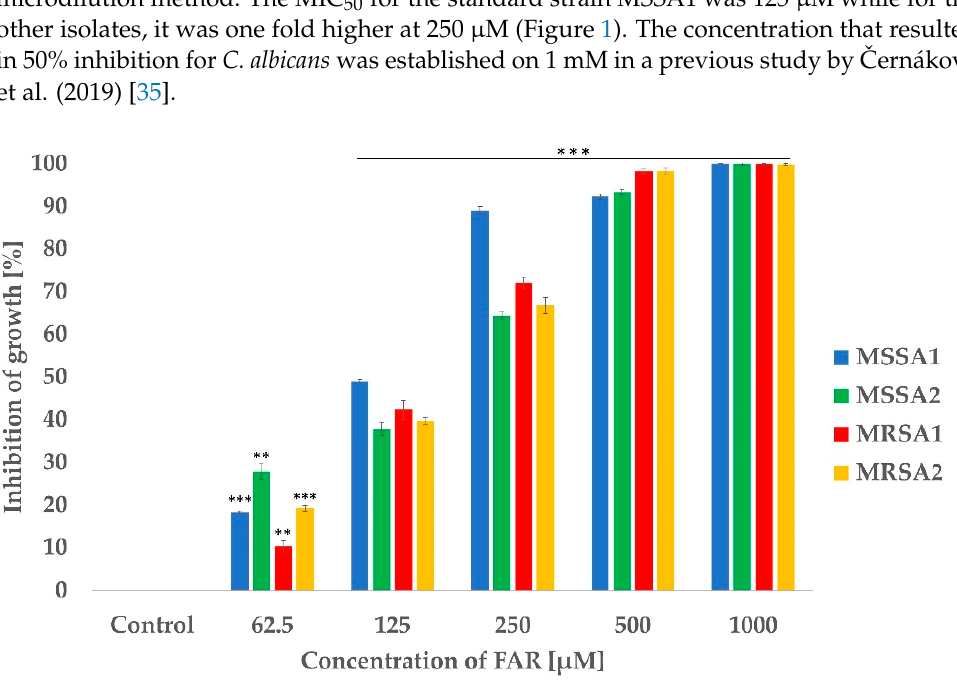
Figure 1. Inhibitory effect of FAR on the planktonic cells of S. aureus determined by MIC 50 in the presence of different concentrations of FAR; the control sample was without FAR. Percentage of growth inhibition was calculated from the OD 570 values of samples compared to the inhibition of the control sample set to 0%. Data represent the average of 3 independent experiments performed in triplicate. A p < 0.01 (**) was considered statistically highly significant; p < 0.001 (***) was considered extremely significant.